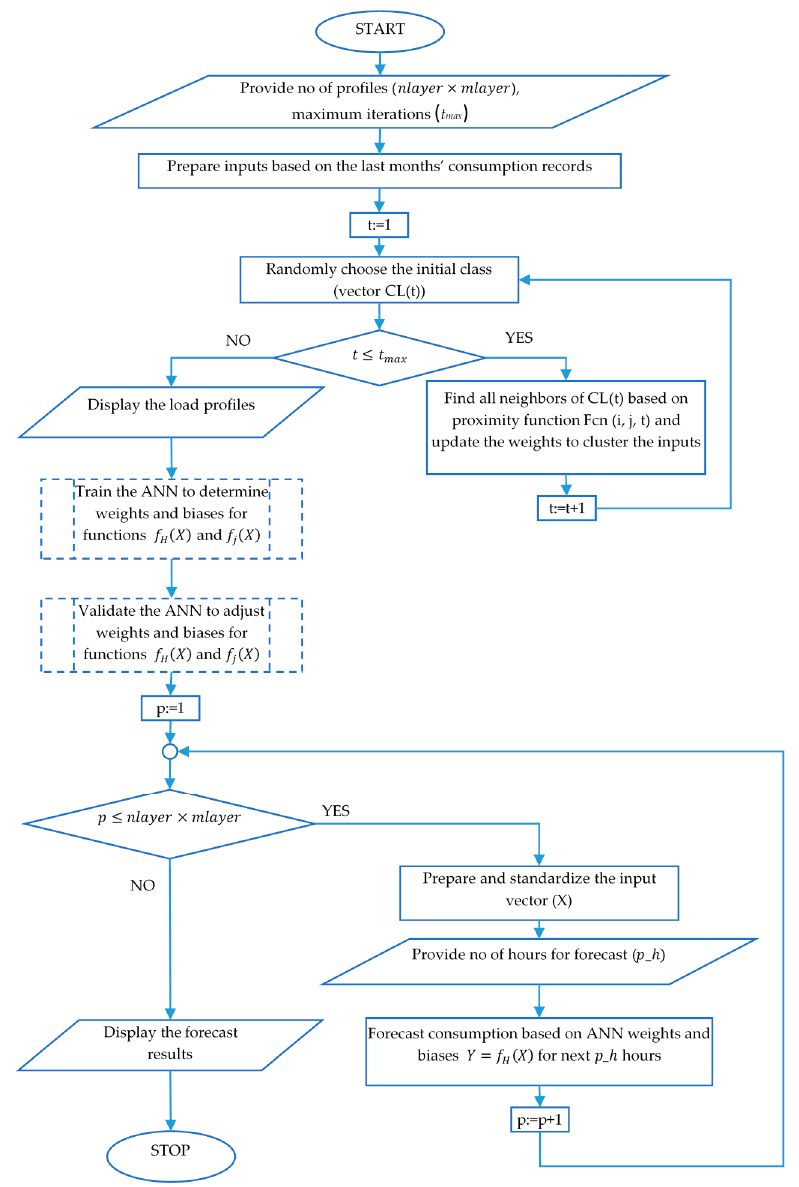
Figure 8. Flowchart of load profiles algorithm and consumption forecast algorithm.